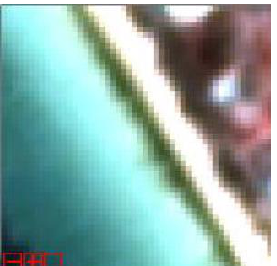
Figure 7: Zoom display of sample area with visible algae presence from April 25, 2018